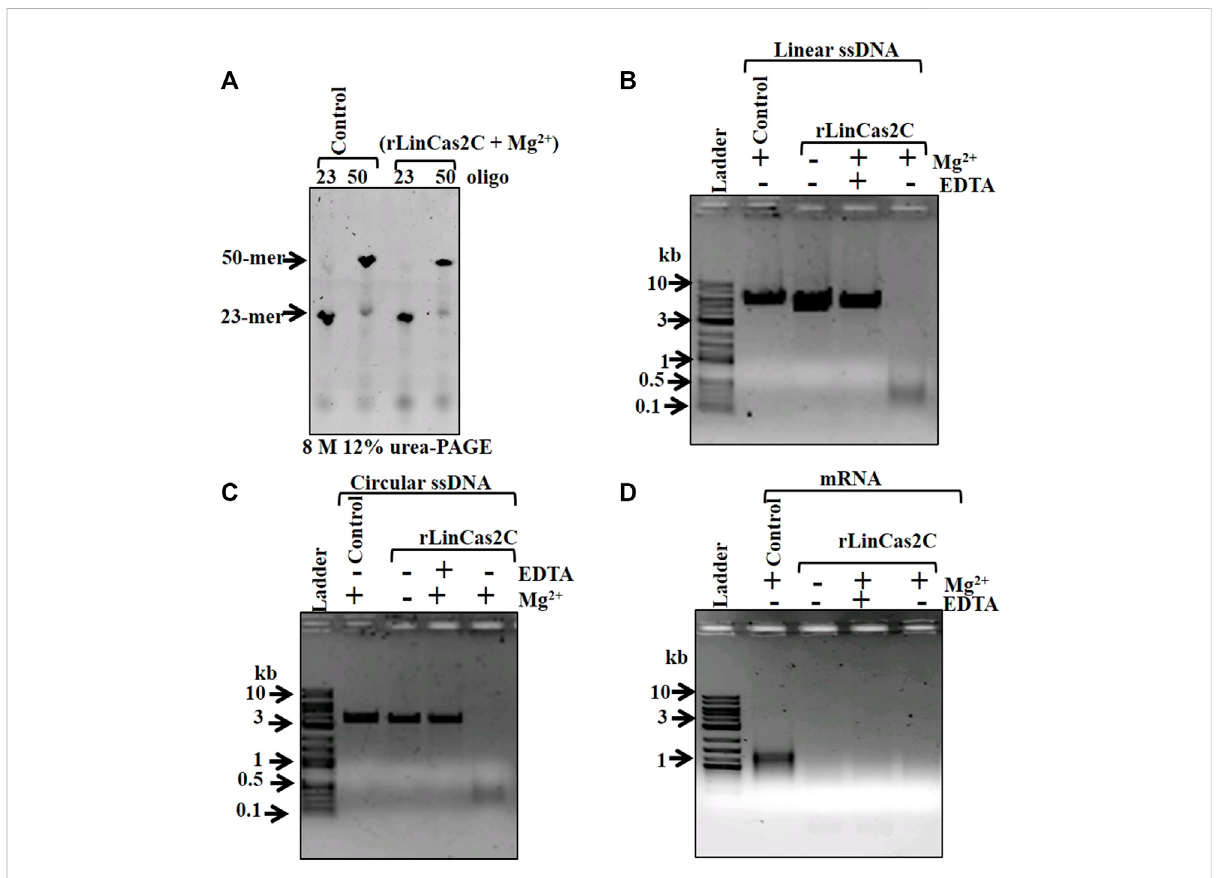
FIGURE 3 Nuclease activity of rLinCas2C on single-stranded DNA and RNA. The nuclease activity reaction was carried out at 37 ° C for an hour. (A) DNase activity of rLinCas2C on synthesized single-stranded linear DNA (oligo-1: 23-mer 0.4 µM, oligo-2: 50-mer 0.4 µM). The nuclease reaction product was analyzed on 8 M 15% urea-PAGE. (B) DNase activity of rLinCas2C on linear single-stranded DNA (0.5 µg of 6.4 kb M13mp18). Complete degradation of linear single-stranded was observed in the presence of Mg 2+ ions. (C) DNase activity of rLinCas2C on circular single-stranded DNA (3.6 kb ϕ x174, 0.5 µg). Complete degradation of circular single-stranded was observed in the presence of Mg 2+ ion. (D) RNase activity of rLinCas2Con luciferase mRNA(0.5 µg).CompletedegradationofRNAwasobservedevenintheabsenceofMg 2+ ions.DNAladder:2logDNAladder (NEB). rLinCas2C: 25 µM and Mg 2+ : 2.5 mM. The nuclease reaction products shown in Figure (B) , (C) , and (D) were analyzed on 2% agarose